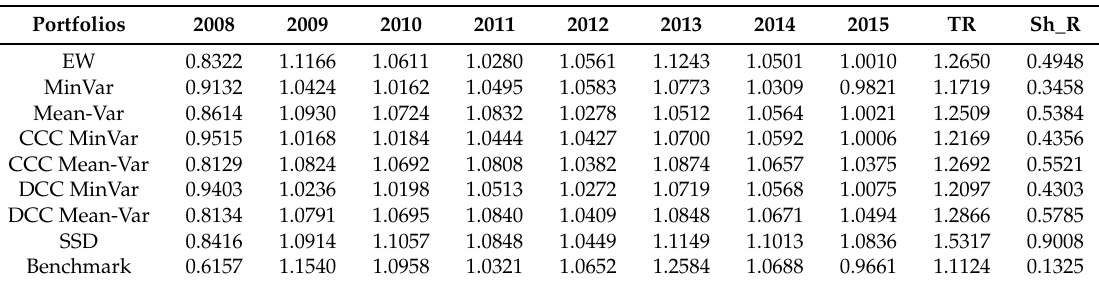
In Table 4 (DJ stocks, t = 1000), the SSD constrained portfolio has the highest T_R (1.5317) and Sh_R (0.9008). Table 4. Yearly compounded returns, Total compounded Return (T_R) and Sharpe Ratio (Sh_R) for DJ stocks (t = 1000).